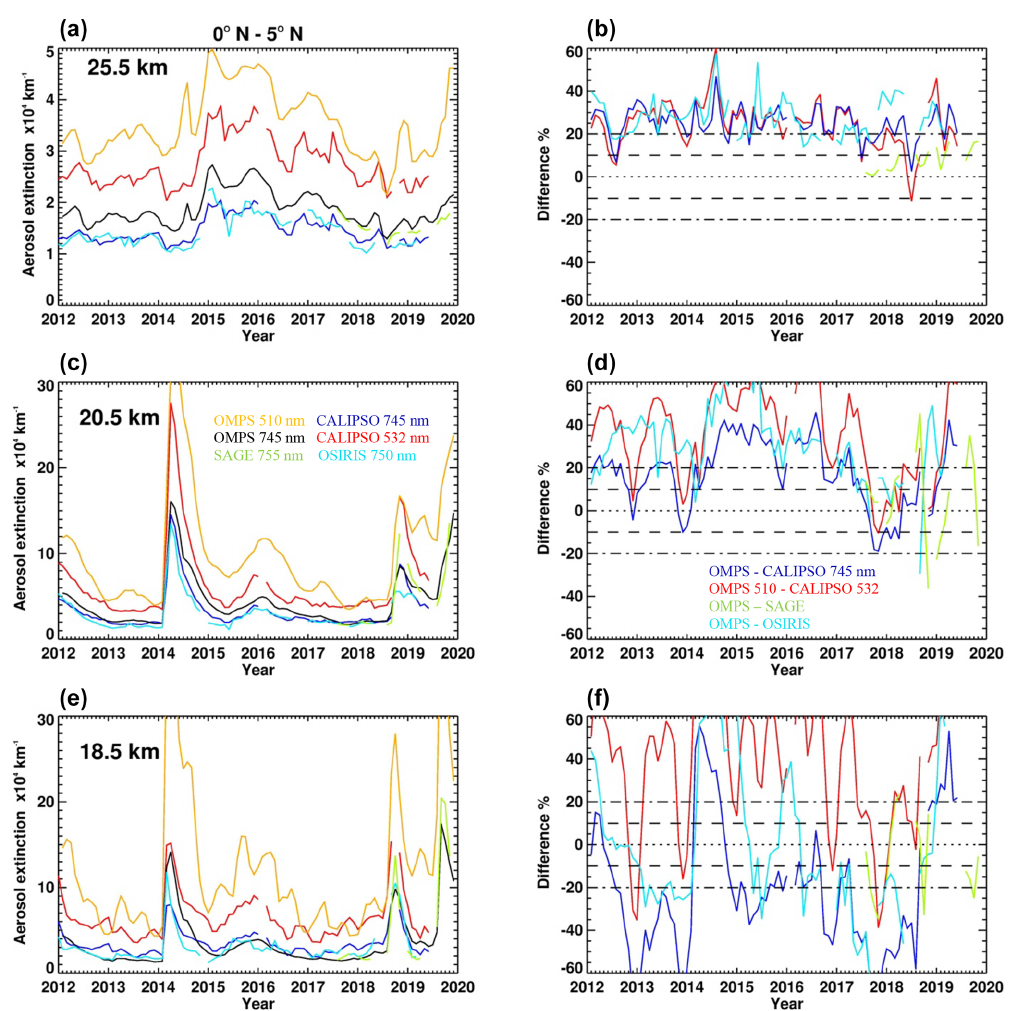
Figure 13. Panels (a) , (c) and (e) are CALIPSO 532 (red) and 745 (blue), OMPS LP 510 (orange) and 745 (black), OSIRIS 750 (light blue), and SAGE III/ISS 755nm (green) aerosol extinction monthly zonal mean, latitude zone 0 and 5 ◦ N for altitudes 25.5 (top), 20.5 (middle) and 18.5km (bottom), from 2012 to 2019. Panels (b) , (d) and (e) are the percent difference between OMPS LP and other